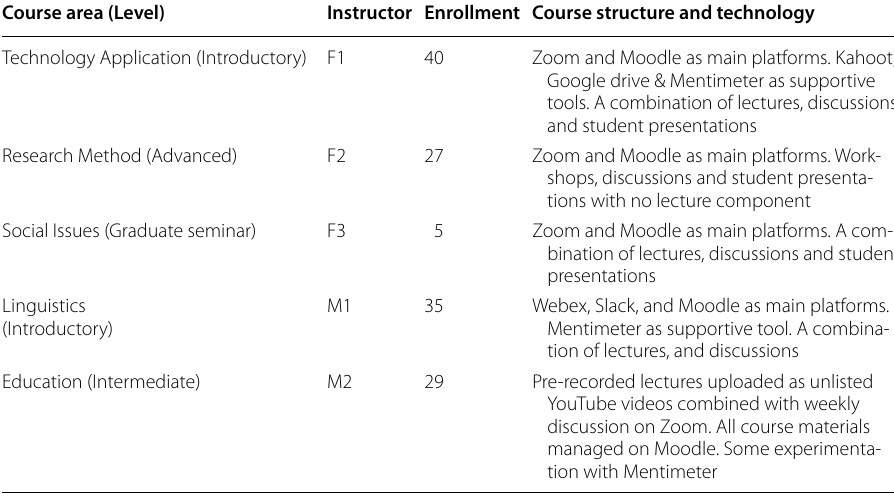
Table 2 Five online courses selected for journal writing Course area